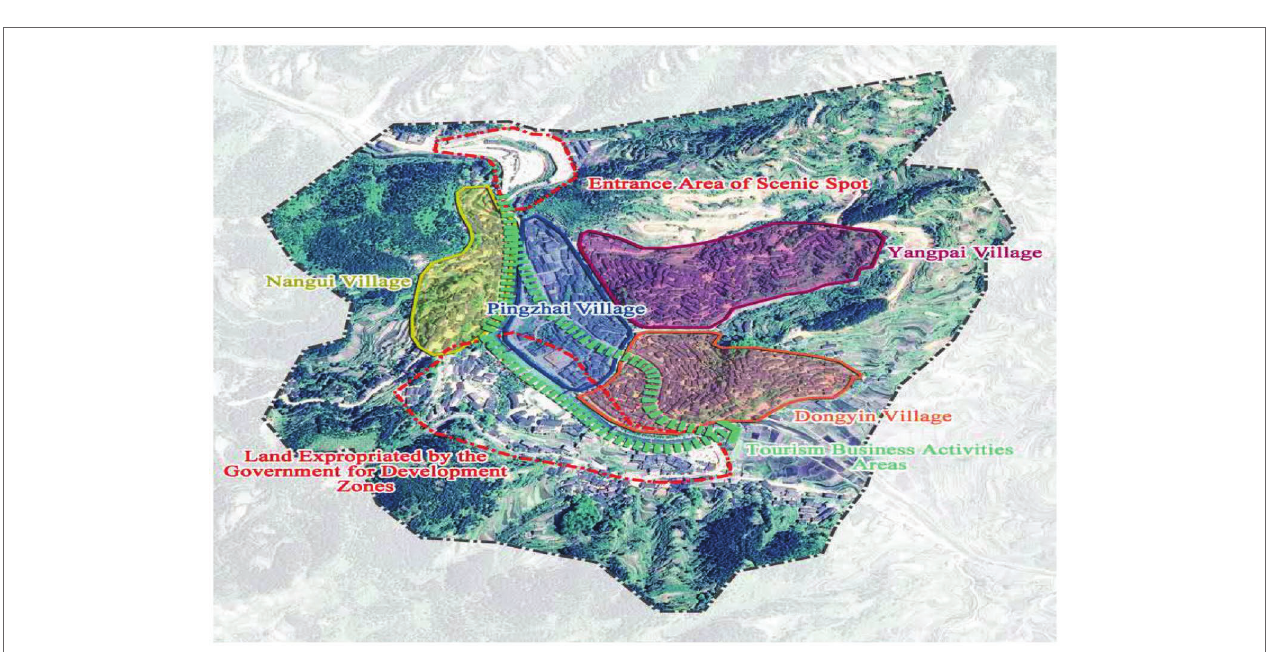
FIGURE 2 | Bird’s eye-view of Xijiang Miao Village (Source: The official website of Xijiang Miao Village: http://www.xjqhmz.com/).